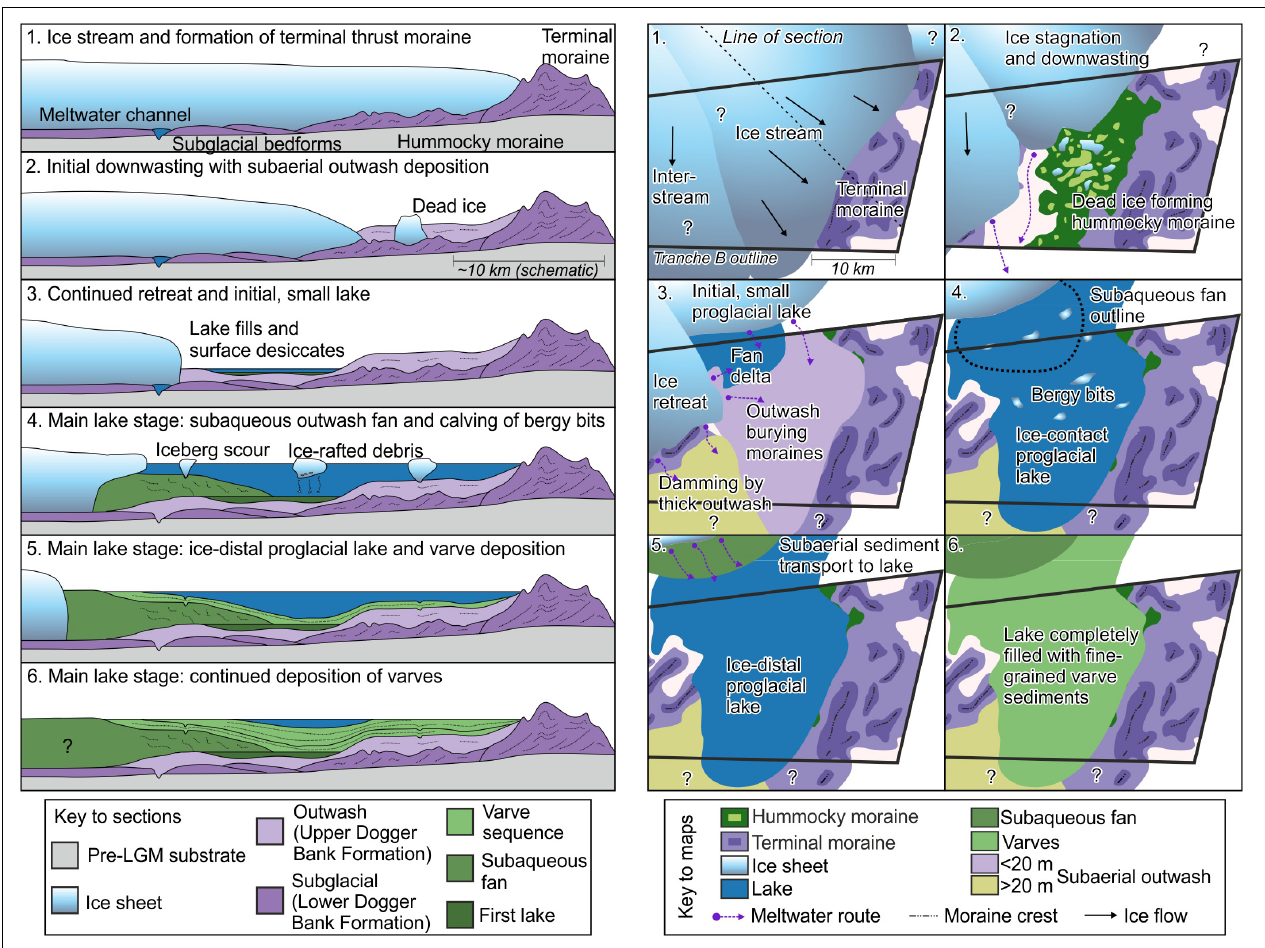
FIGURE 8 | Conceptual landscape evolution model during ice-sheet retreat in the study area. Schematic cross-section stages show stratigraphic evolution of the ice stream and proglacial lake. Paleogeographic maps show the spatial landscape evolution and lateral changes in ice sheet margin. Numbers correspond to stages described in section “Paleogeographic Evolution of Southeastern Dogger